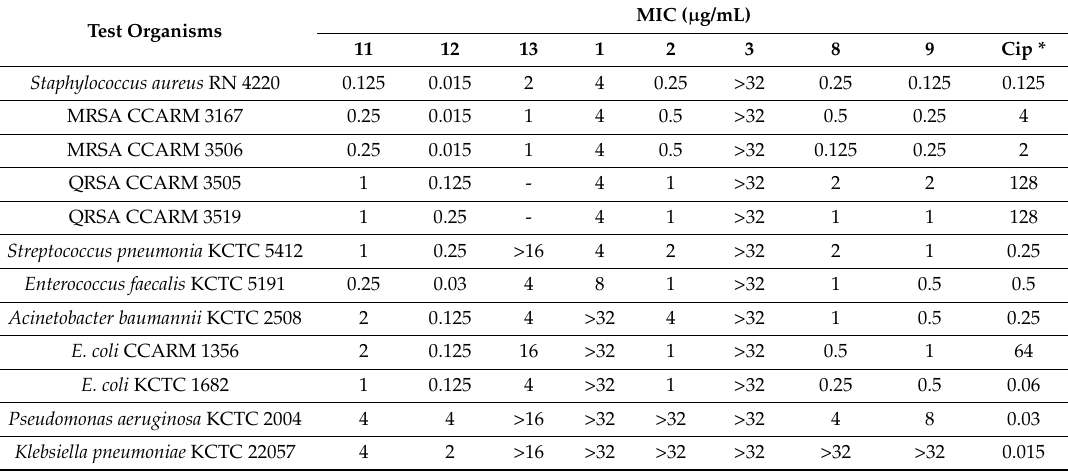
Table 6. Antibacterial activities of 1 – 3 and related compounds.